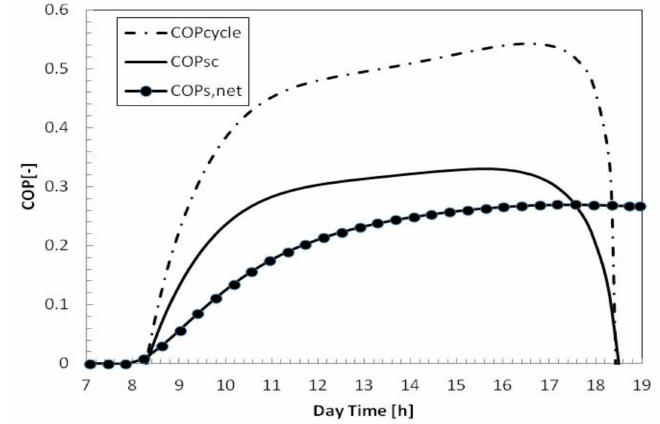
Figure 8. Variation of cycle coe ffi cient of performance (COP), solar COP, and net solar COP for a typical day in January at